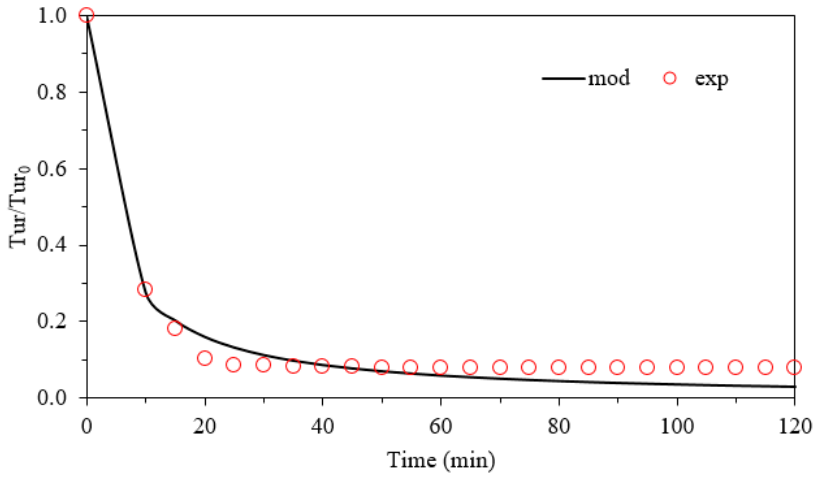
Figure 2. Olive mill wastewater (OMW) coagulation/flocculation kinetic results and modeling (chitosan concentration = 500 mg L − 1 , temperature = 25 °C, initial turbidity 3.89 g L − 1 ).